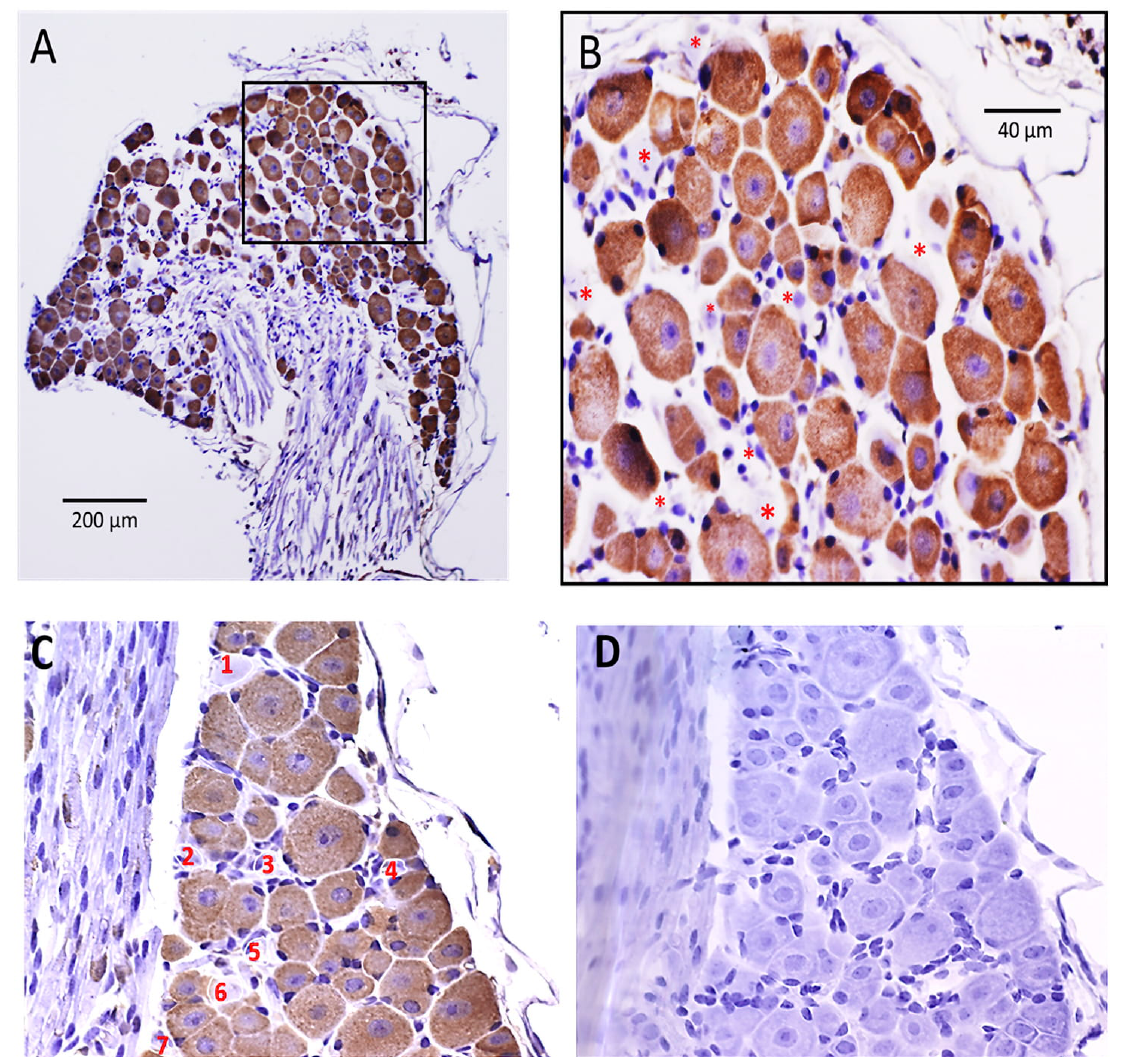
Fig.1. ImmunohistochemicallocalizationofPiezo2inmouseDRG. (A)Theanti-PIEZO2AbstainedmostDRGneuronsindependentofsomasize(range 10–50 µ m in diameter). (B) Higher magnification image of the section enclosed within the square in 1A shows that of the ~90 neurons present, only 9 neurons (i.e., indicated by red asterisks) showed no Ab staining, and these appeared to be smaller diameter neurons. The numerous small blue structures (i.e., stained by the nuclear stain hematoxylin) around the perimeter of each neuron represent the cell bodies of satellite glial cells (SGCs) that include their cell nucleus and very thin cytoplasmic processes that ensheath the neurons. The SGCs showed no Ab staining, but this could be an issue of detection rather than a lack of Piezo2 expression. (C) Another DRG slice from a different mouse showed a similar pattern of staining most DRG neurons. (D) An adjacent slice treated with the same IHC protocol except without the anti-PIEZO2 Ab